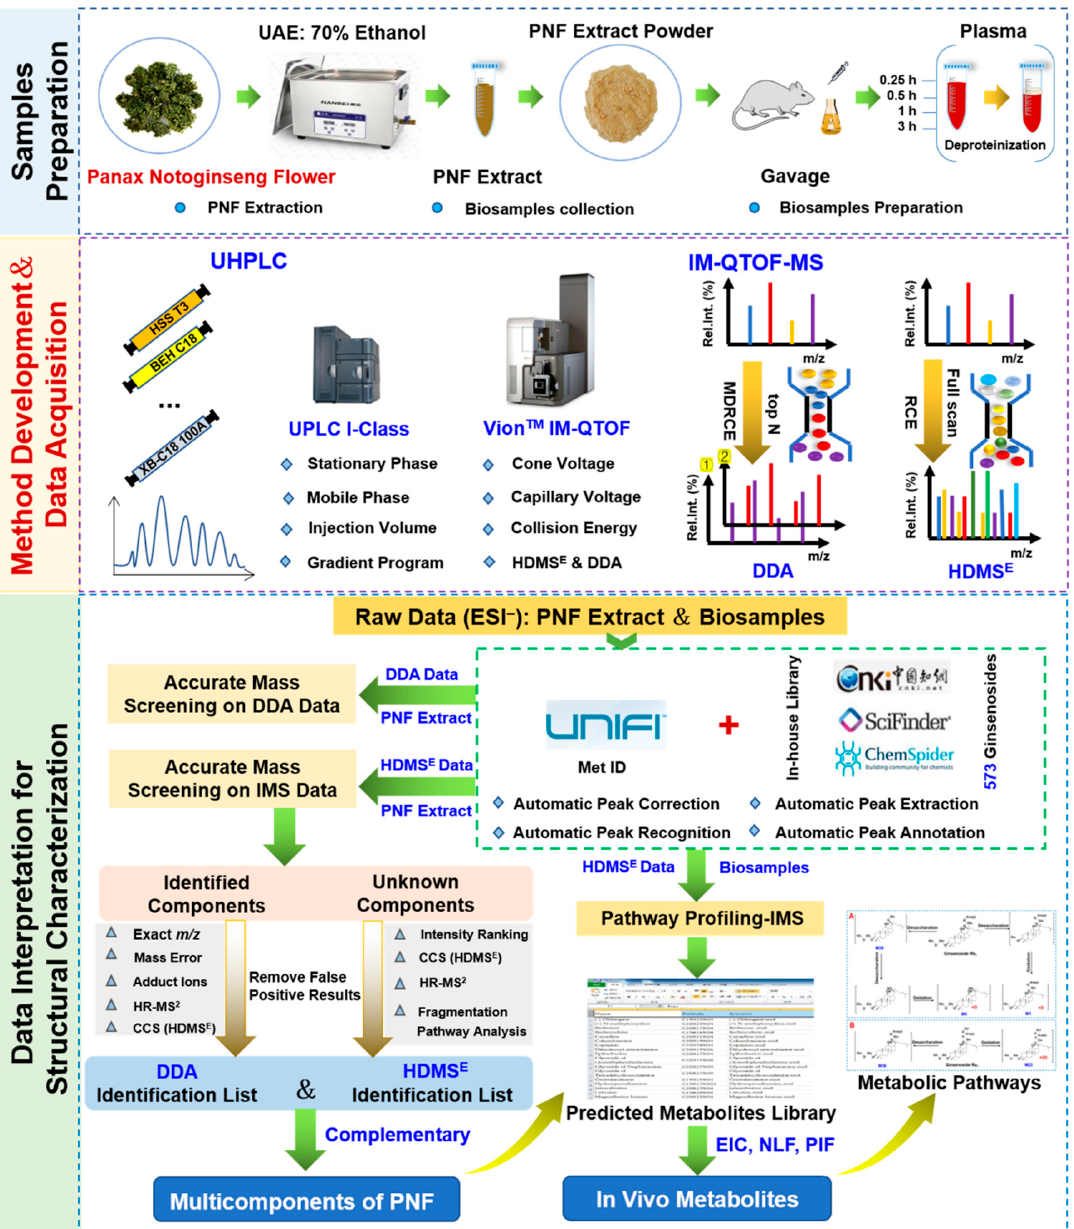
Figure 1. General technical flowchart for the comprehensive characterization of the multi-components from Panax notoginseng flower bud and its in vivo metabolites in rat plasma by UHPLC/IM-QTOF-MS and intelligent data processing facilitated by UNIFI TM .